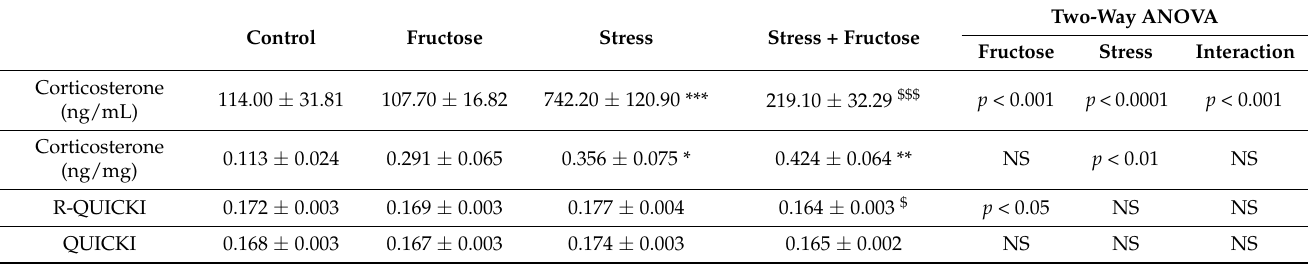
The data are presented as means ± SEM ( n = 8–9 animals per group). A value of p < 0.05 was considered statistically significant. Significant between-groups differences obtained from two-way ANOVA followed by post hoc Tukey test are given as follows: * p < 0.05, ** p <